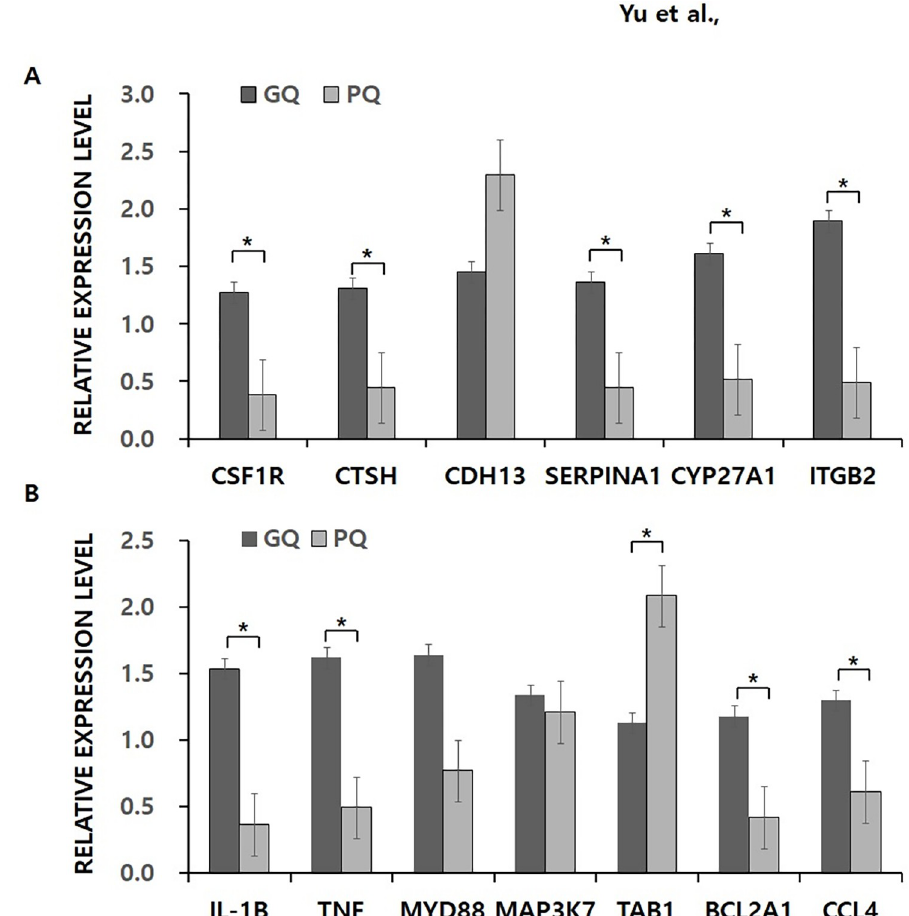
Fig 4. Validation of RNAseq results using RT-qPCR of 13 targets normalized to GAPDH in duplicate. Fold change was calculated using the 2 ΔΔ Ct method between the good-quality (GQ) and poor-quality (PQ) embryos. � p < 0.05. (A) Six genes associated with embryo quality both in our and previous studies. (B) Seven genes randomly selected from the NF-kB pathway.